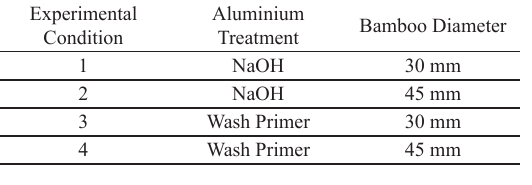
Table 1. Full Factorial Design (2 2 ).